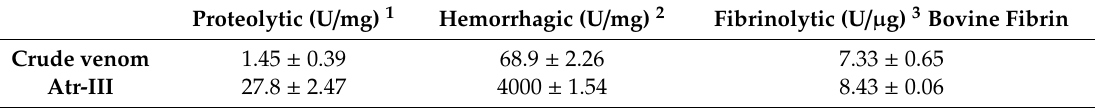
Table 1. Some biological activities of Atroxlysin-III from B. atrox